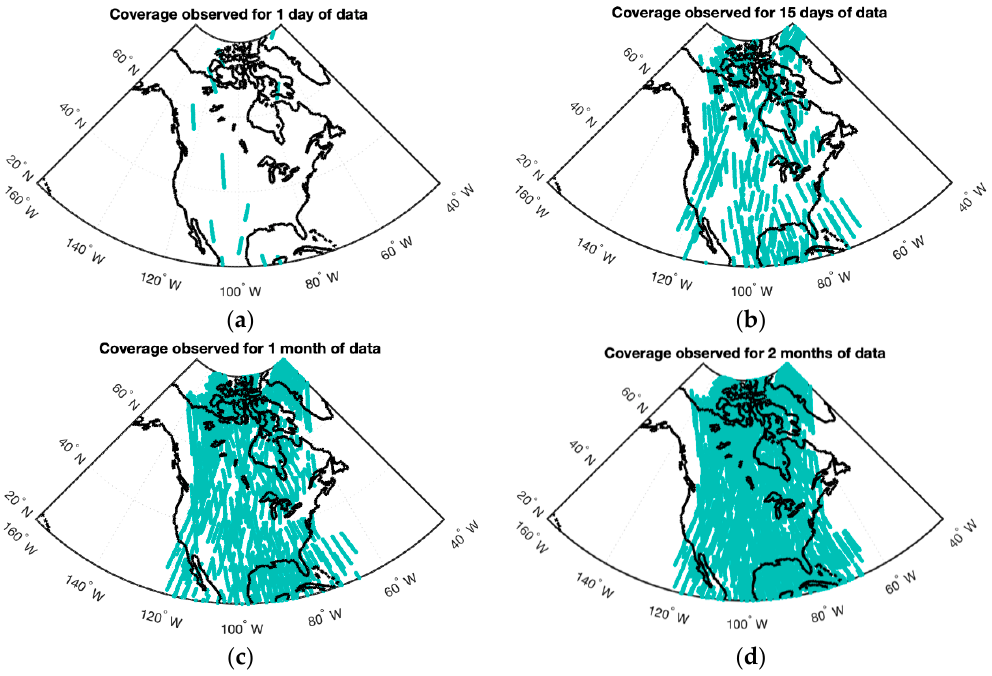
Figure 2. SMAP-R coverage observed for ( a ) 1 day (285 observations), ( b ) 15 days (7168 observations), ( c ) 1 month (14,449 observations), and ( d ) 2 months (30,500 observations).